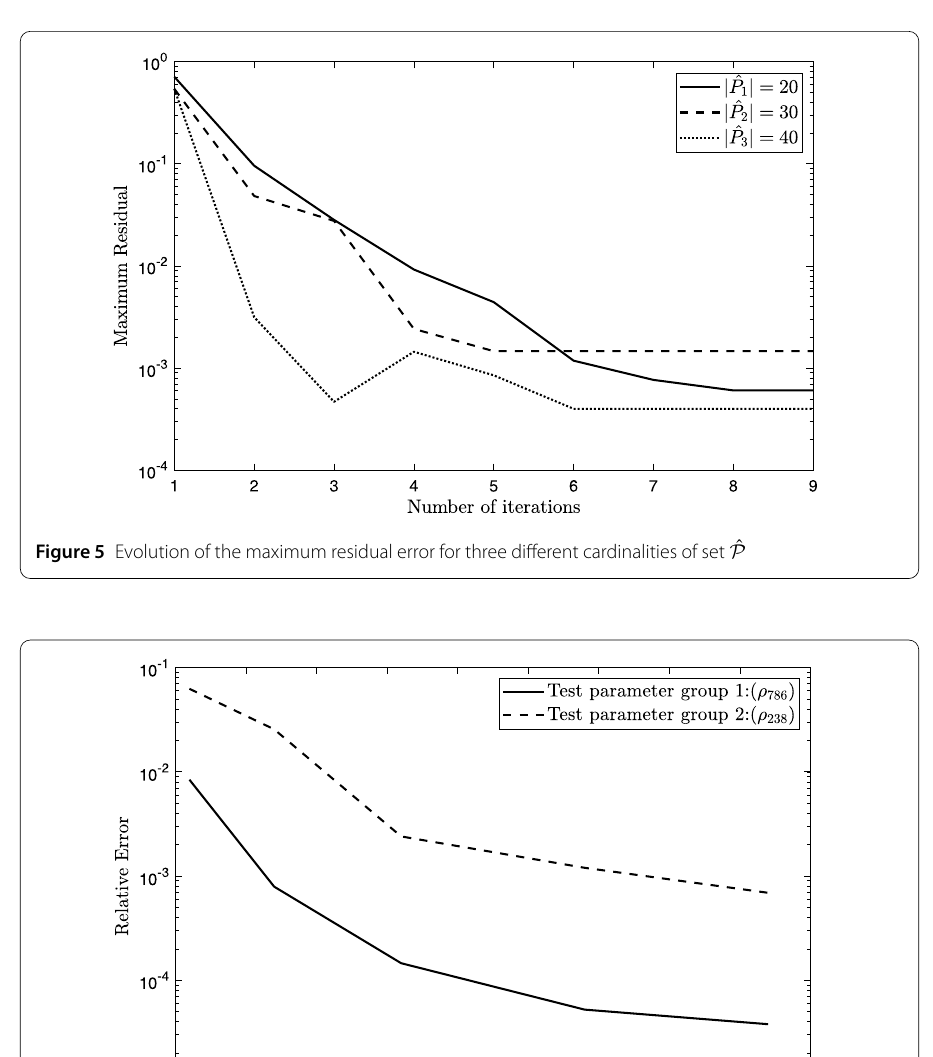
the plot of the maximal residual against the number of iterations for three different cardi-